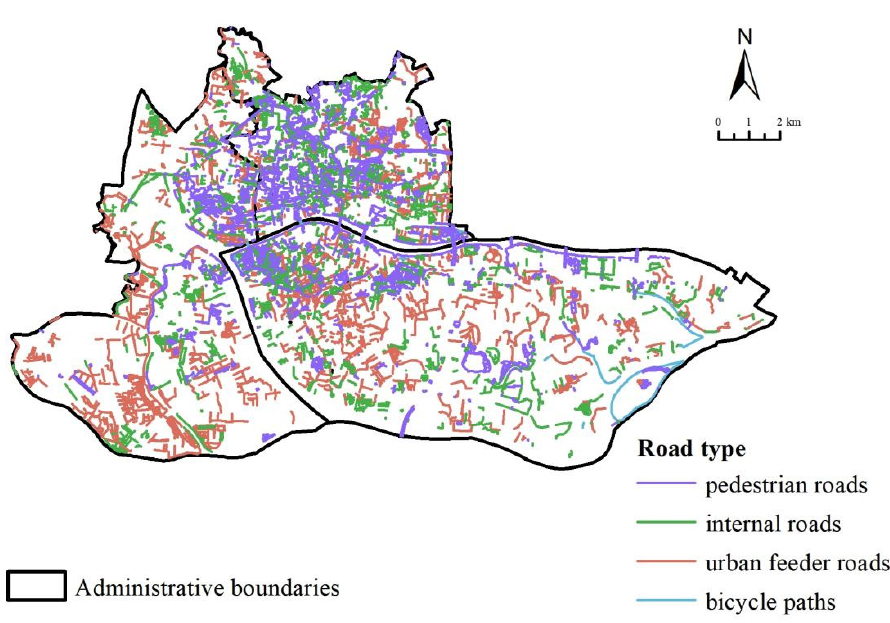
Figure 2. Spatial distribution of Road Types in the Three Central Districts of Guangzhou.